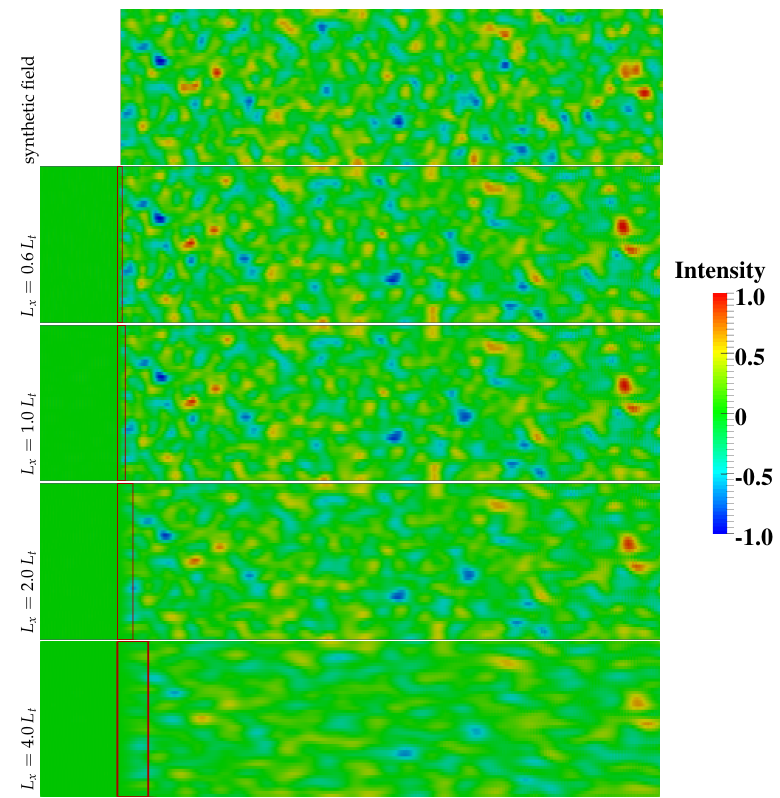
Figure 1. Original fluctuation field (top) and transport as a passive scalar with variations of L x . Decreasing intensity of small scale fluctuations with increasing